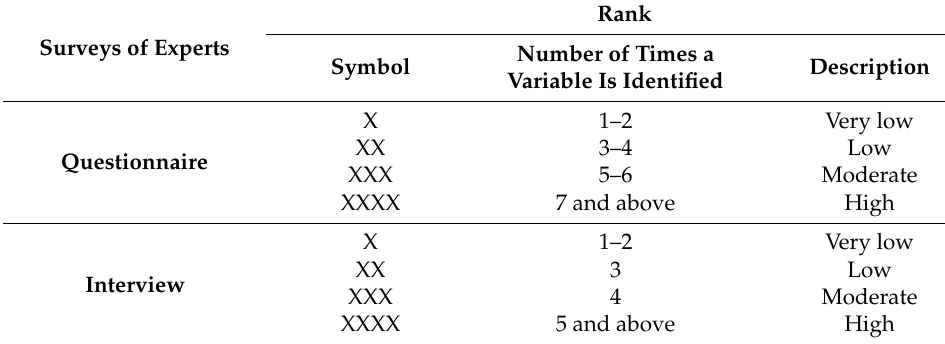
Table 2. Questionnaire and interview ranking methods.